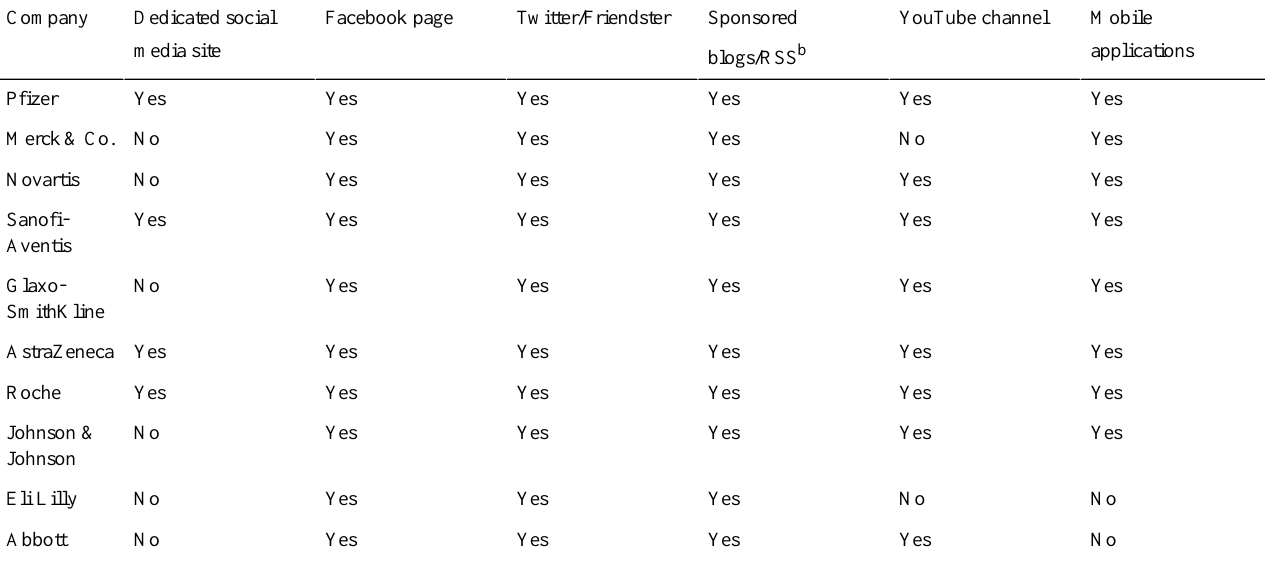
Table 1. Top 10 pharmaceutical companies by sales and eDTCA 2.0 a presence